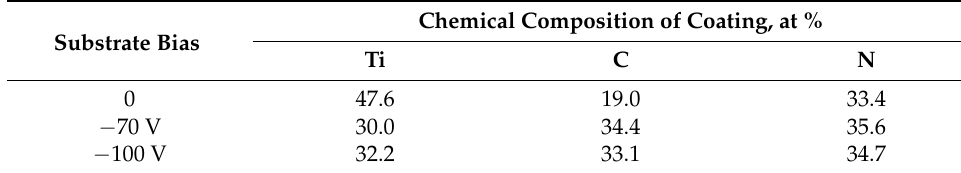
Table 1. Dependence of the elemental composition of TiCN coatings on U s .